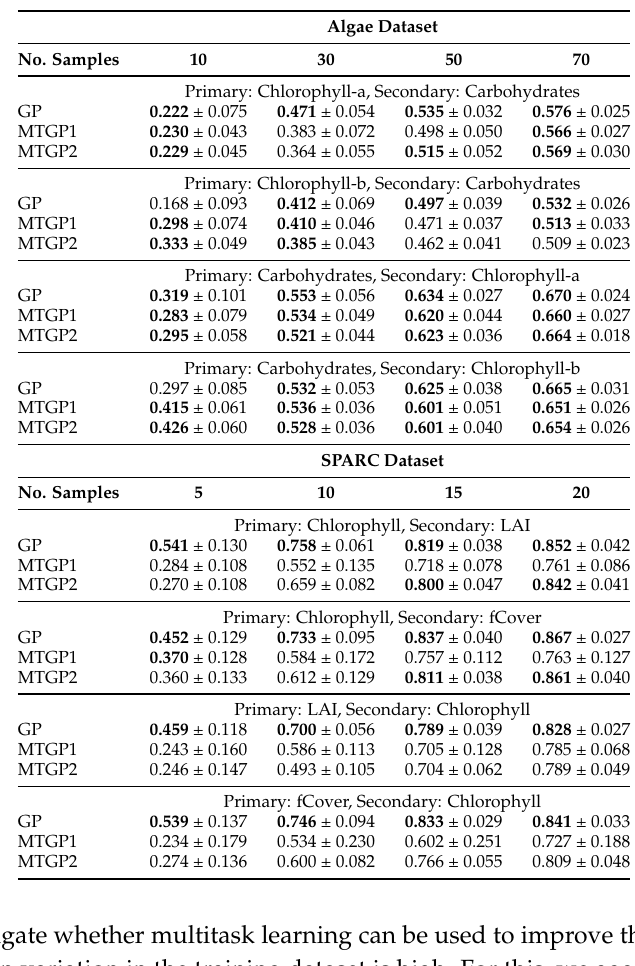
Table 6. Comparison of GP and multitask GP for vegetation parameter prediction (negative results). Performance measured by R 2 .